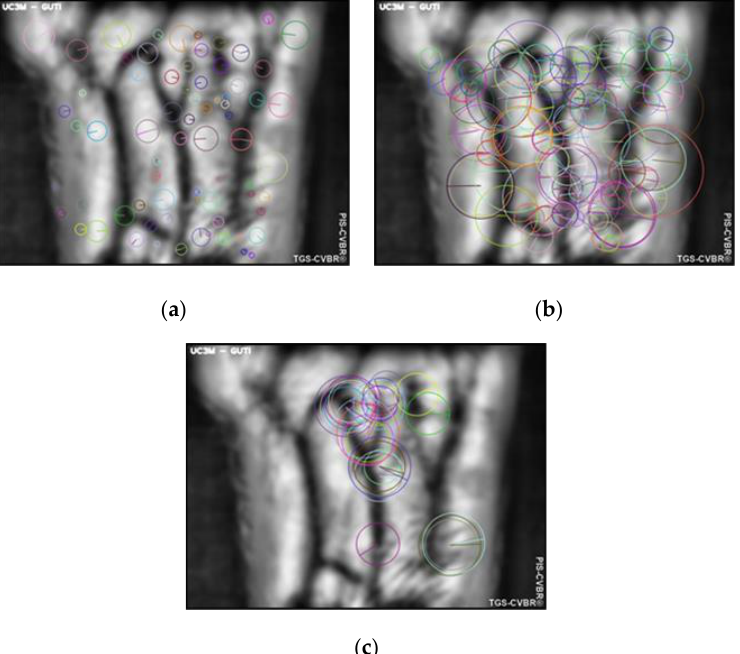
Figure 4. PIS-CVBR ® : Feature extraction for User 0. Scale and orientation of the 100 key points extracted with the three algorithms used: ( a ) Scale-Invariant Feature Transform (SIFT ® ). ( b ) Speeded Up Robust Features (SURF ® ). ( c ) Oriented FAST and Rotated BRIEF (ORB).